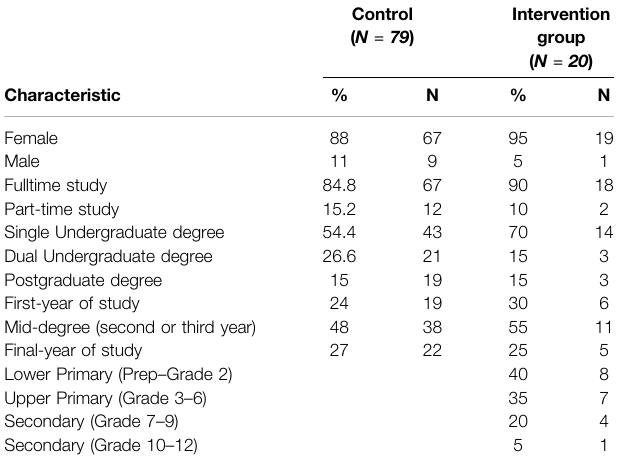
TABLE 2 | Study two participant